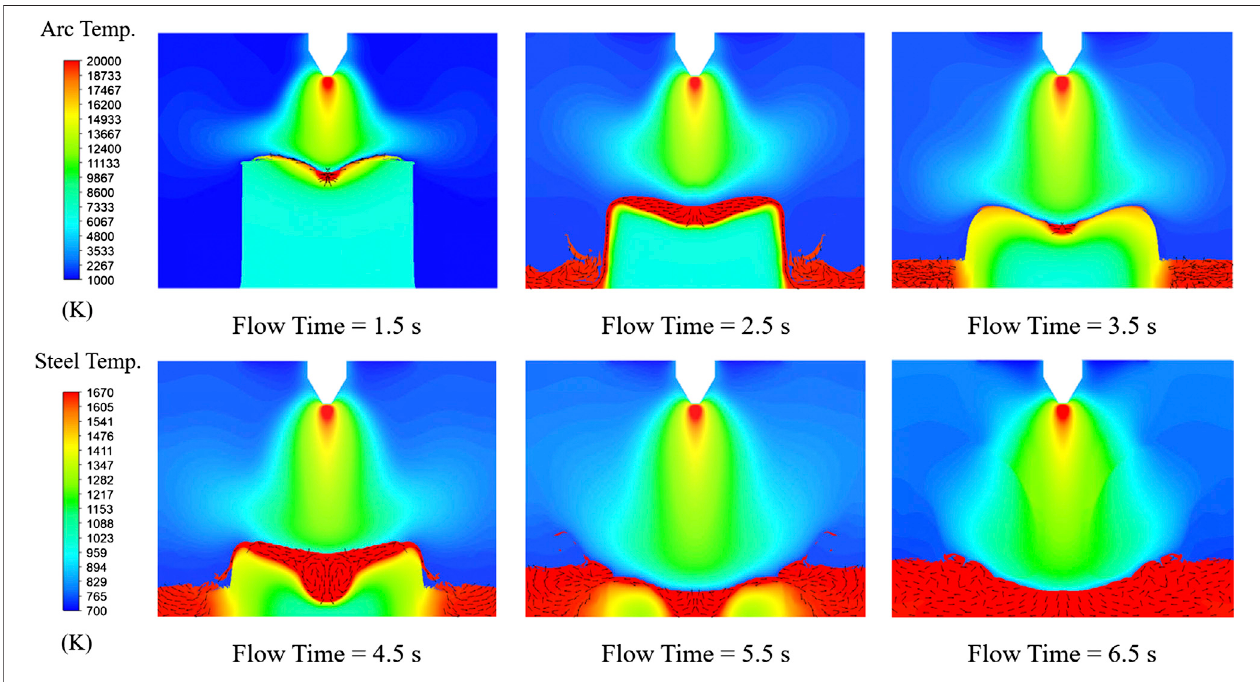
FIGURE 8 | Steel ingot melting using electric arc with stationary